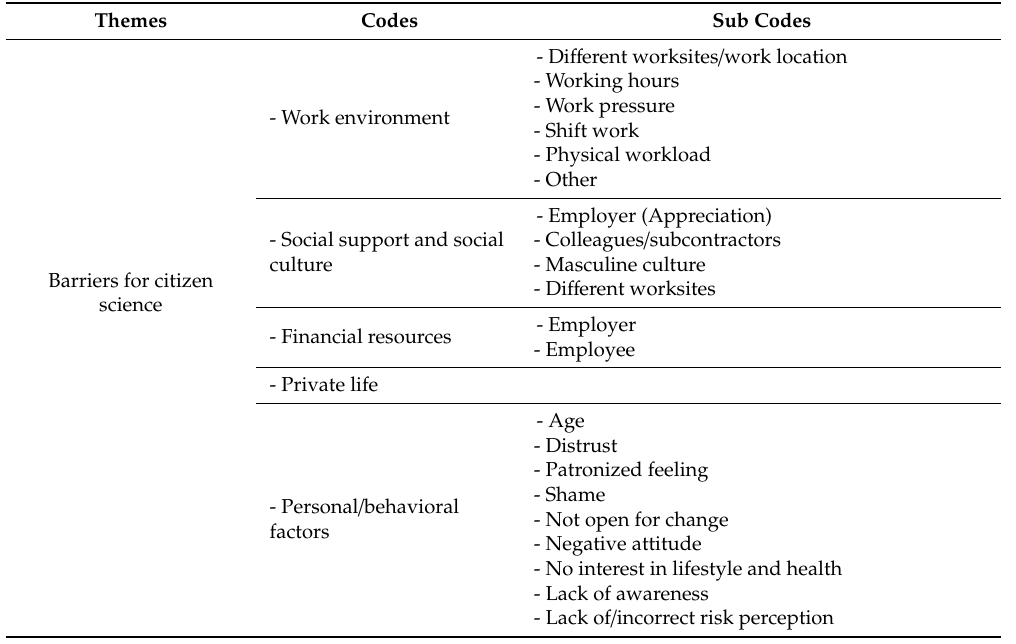
Table A1. Codes and